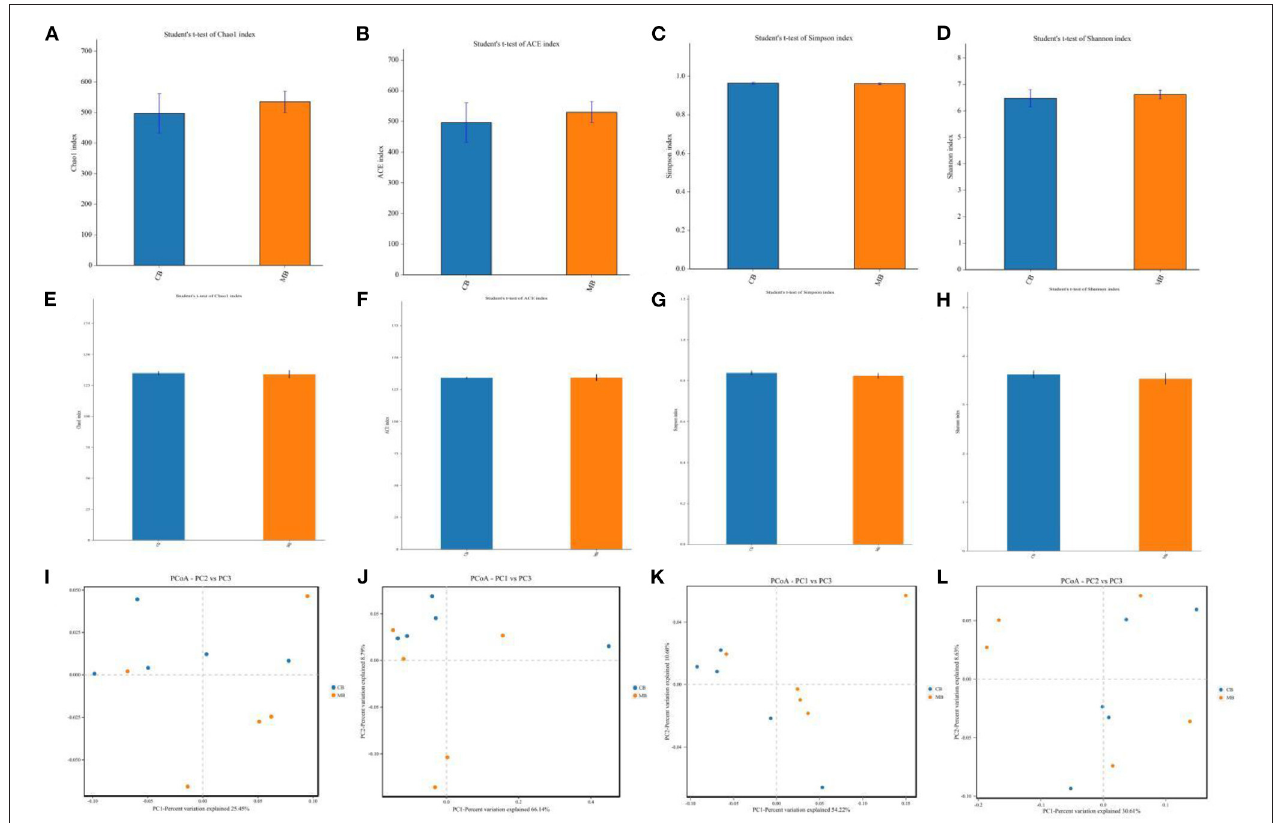
FIGURE 2 | Changes of gut bacterial and fungal diversities associated with mastitis in buffalos. (A–D) Represent gut bacterial Chao, ACE, Simpson, and Shannon indices, respectively. (E–H) Represent gut fungal Chao, ACE, Simpson, and Shannon indices, respectively. (I,J) Represent gut bacterial PCoA maps, whereas (K,L) Represent gut fungal PCoA